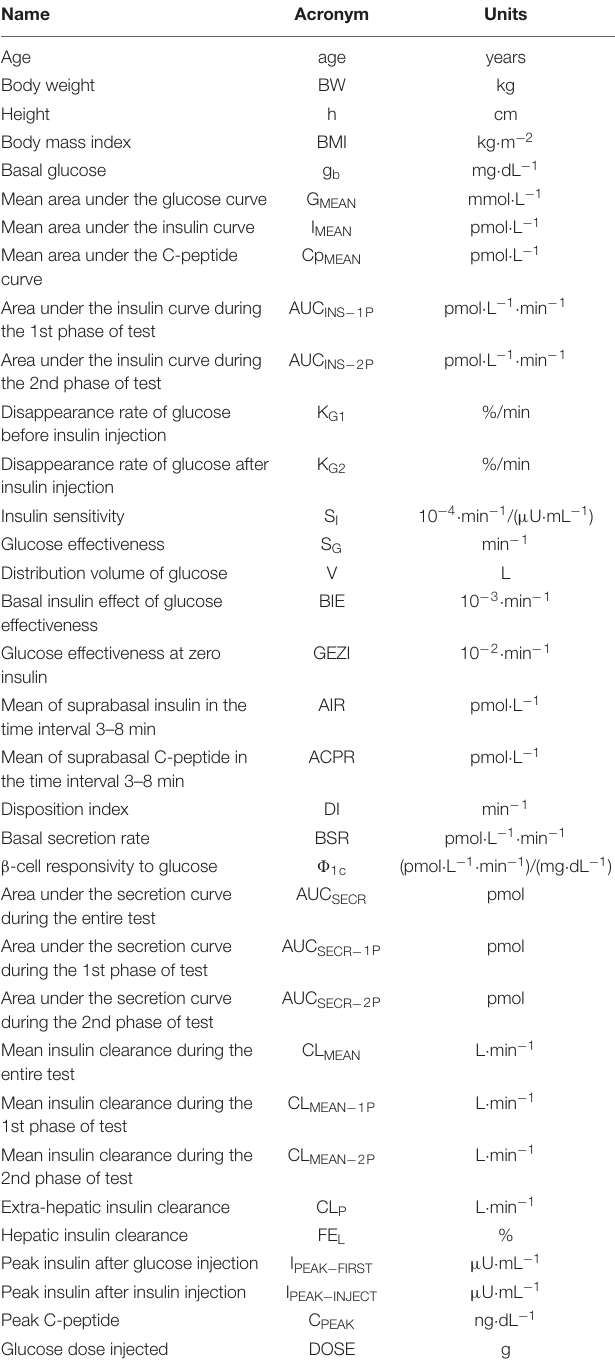
TABLE 1 | Description of all the features included in the generated data